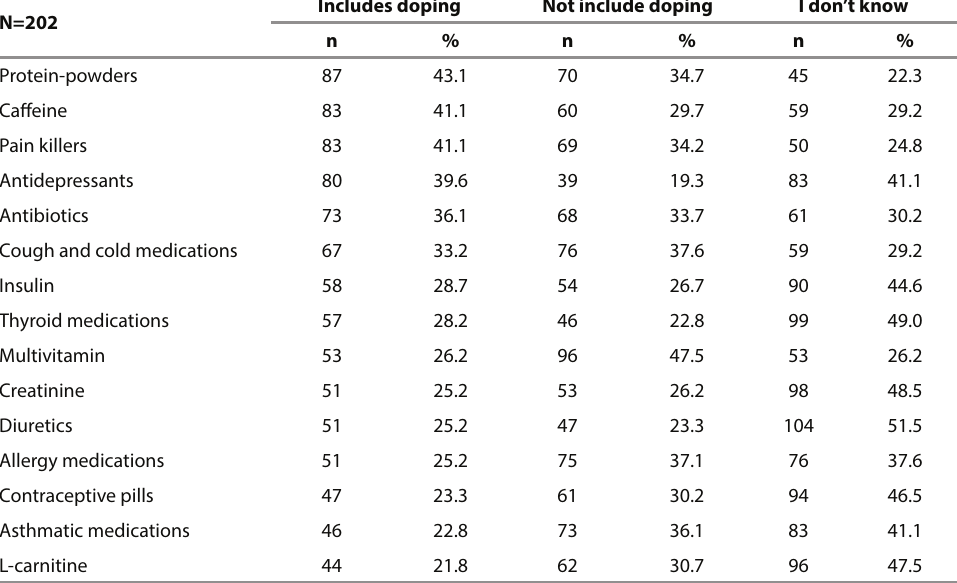
TABLE 3. Athletes’ awareness of medications or supplements prohibited by WADA for causing a doping violation Includes doping Not include N=202